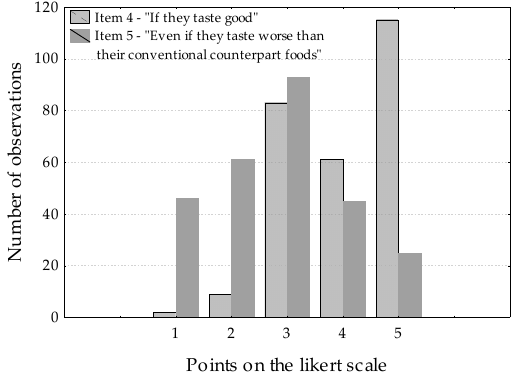
Figure 1. Frequency distribution on the Likert scale for the functional food acceptance variable ( n = 270).